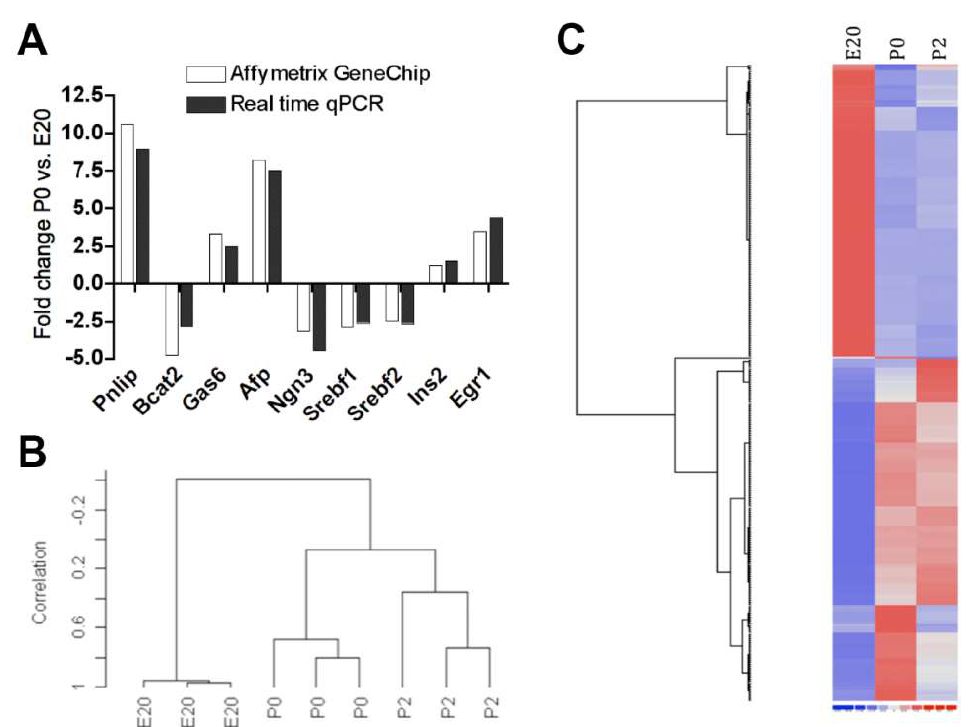
Figure 1. ( A ) Comparison of fold changes (FCs) in mRNA expression levels between P0 and E20 as obtained by hybridization to Affymetrix GeneChip versus RTqPCR for the number of selected up- and downregulated genes. There are no error bars, since data are presented as fold changes. Note: Pnlip: pancreatic lipase; Bcat2: branched-chain amino acid transaminase 2; Gas6: growth-arrest- specific 6; Afp: alpha-fetoprotein; Ngn3: neurog3; Srebf1/2: sterol regulatory element binding protein 1/2; Ins2: insulin 2; Pdx1: pancreatic duodenal homeobox 1; Egr1: early growth response factor 1. ( B ) Dendrogram for clustering using centered correlation and average linkage. Samples from P0 and P2 cluster closer together, indicating a more similar profile compared to samples from E20. ( C ) Heat map generated from the dCHIP hierarchical cluster analysis. Note: E20: embryonic day 20; P0: day 0 postpartum; P2: day two postpartum. Blue: Low expression. Red: High expression. Table 1. Fold changes (FCs) in most up- or downregulated annotated transcripts in control (CO) diet perinatal pancreas samples with corresponding changes listed for low-protein (LP) diet samples. Increased at P0 vs. E20 Increased at P2 vs.